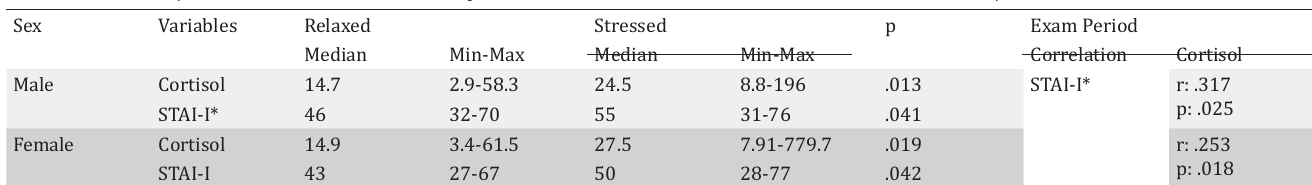
Median (Min-Max) values of cortisol and STAI-I, Wilcoxon paired-samples test results between relaxed and stressed, Spearman rho correlation analysis results between cortisol level and STAI-I in exam period